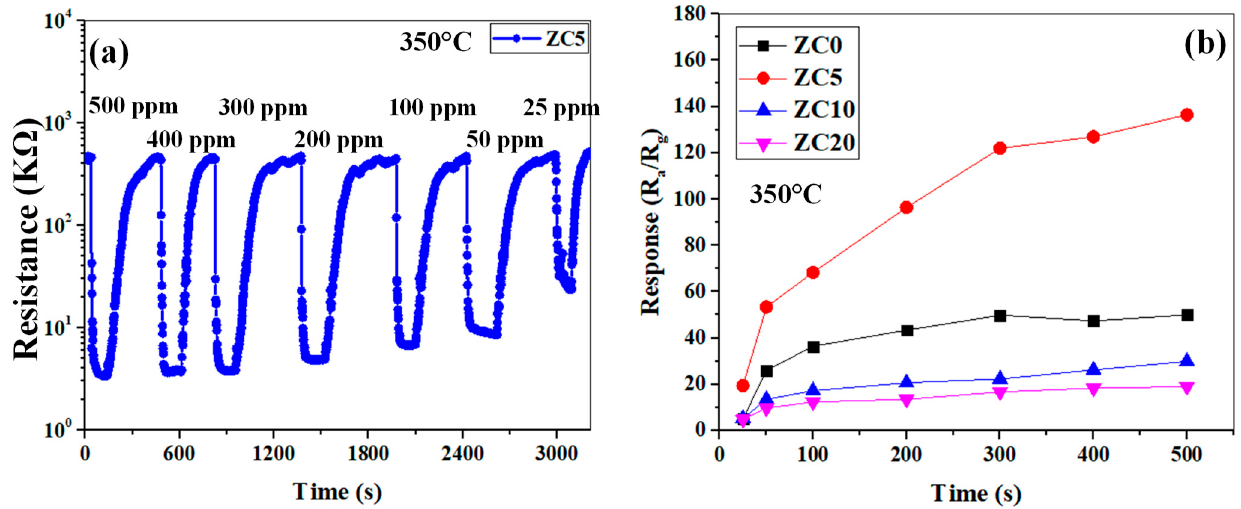
Figure 10. ( a ) Dynamic resistance curve of ZC5 gas sensors to various concentrations of ethanol at 350 °C. ( b ) Calibration curves of pristine and CuO-decorated ZnO gas sensors to 25–500 ppm etha- nol at 350 °C.